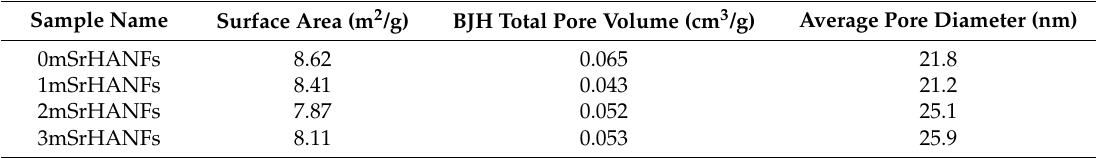
Table 5. BET (Brunauer-Emerett-Teller) surface area, BJH (Barrett-Joyner-Halenda) total pore volume and pore size of mesoporous strontium-substituted hydroxyapatite